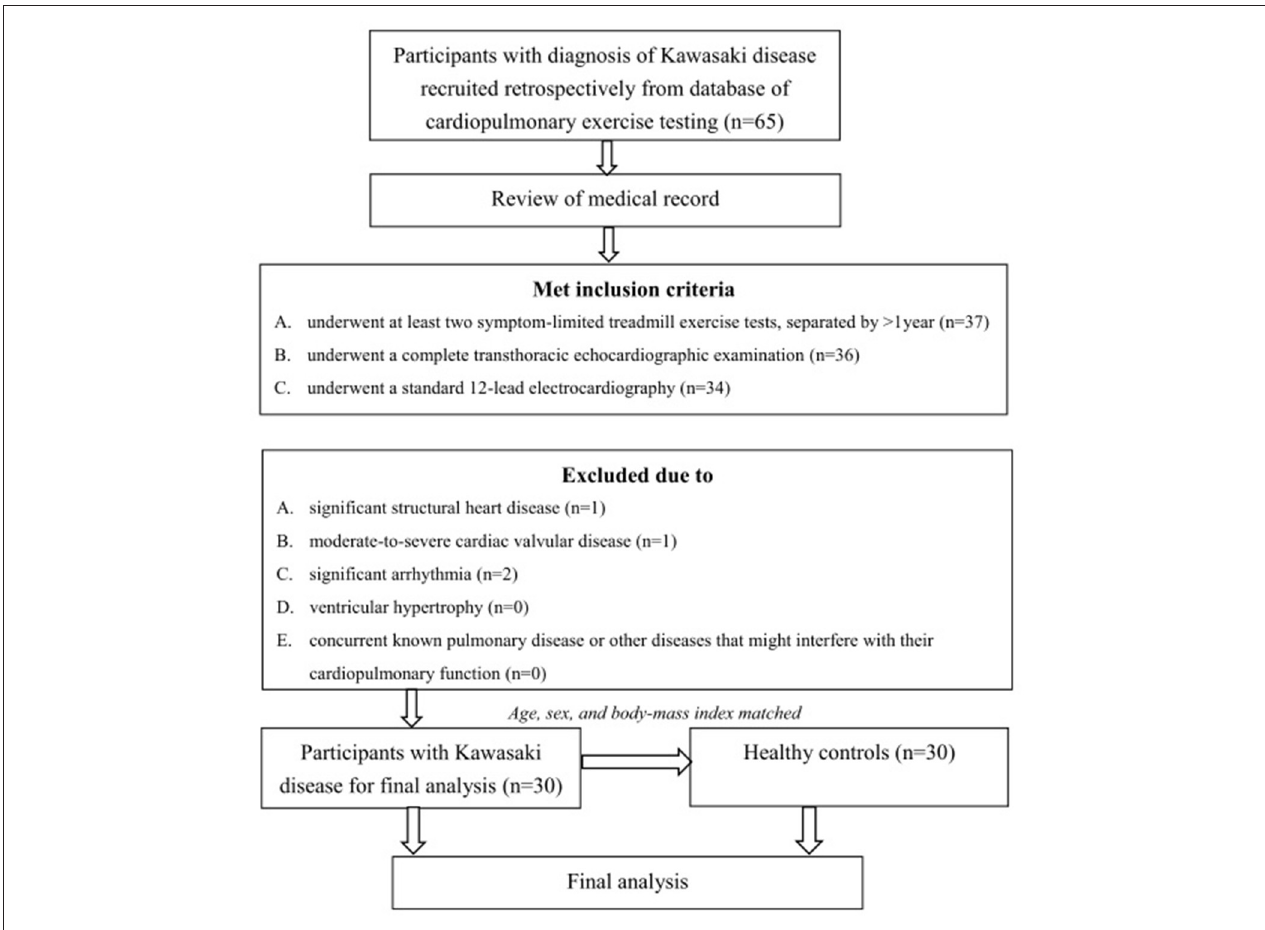
FIGURE 1 | Algorithm of the study. A total of 34 patients met the inclusion criteria. Among them, one patient had moderate valvular disease, one patient had significant cardiac structural problems, and two patients had significant arrhythmia. Therefore, 30 participants with KD were recruited for the final analysis. Thirty age-, sex-, and BMI-matched healthy participants were recruited as the control